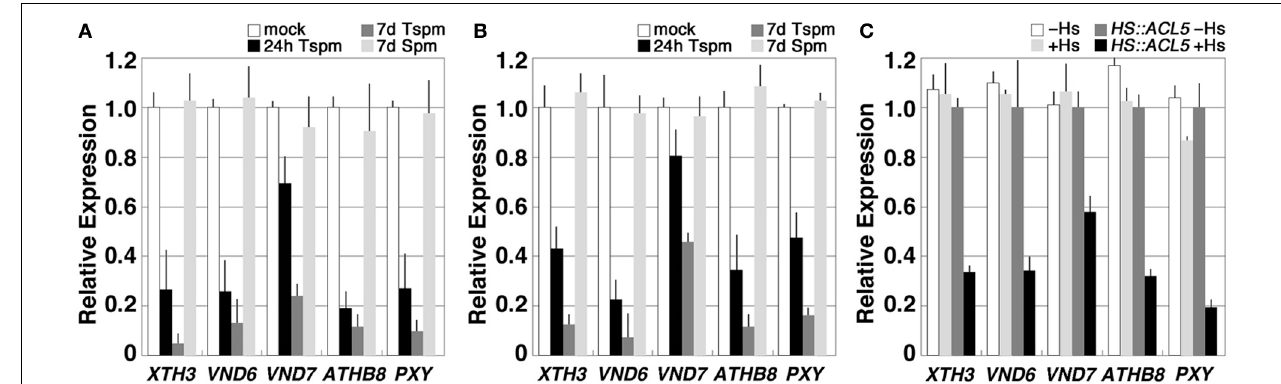
FIGURE 2 | Thermospermine down-regulates the genes that are up-regulated in acl5-1 . (A,B) Effect of exogenous thermospermine and spermine in acl5-1 (A) and wild-type (B) seedlings on the expression of the genes up-regulated in acl5-1 . Transcript levels in seedlings grown for 7 days in MS solutions and incubated for 24h in MS plus 100 µ M thermospermine (black bars) and those in seedlings grown for 7 days in MS solutions supplemented with thermospermine (dark gray bars) or spermine (light gray bars) are shown relative to those in seedlings grown for 7 days in MS solutions with no polyamines (white